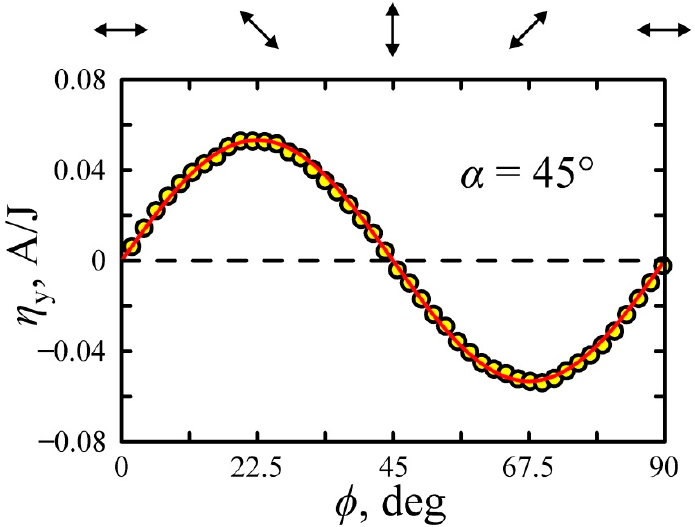
Figure 8. Dependences of the transverse conversion efficiency on half-wave plate orientation ϕ at α = 45°. The solid line shows fitting by Equation (27) at parameters in Table 1. Arrows at the top of the figure show orientation of the polarization azimuth of the excitation beam.